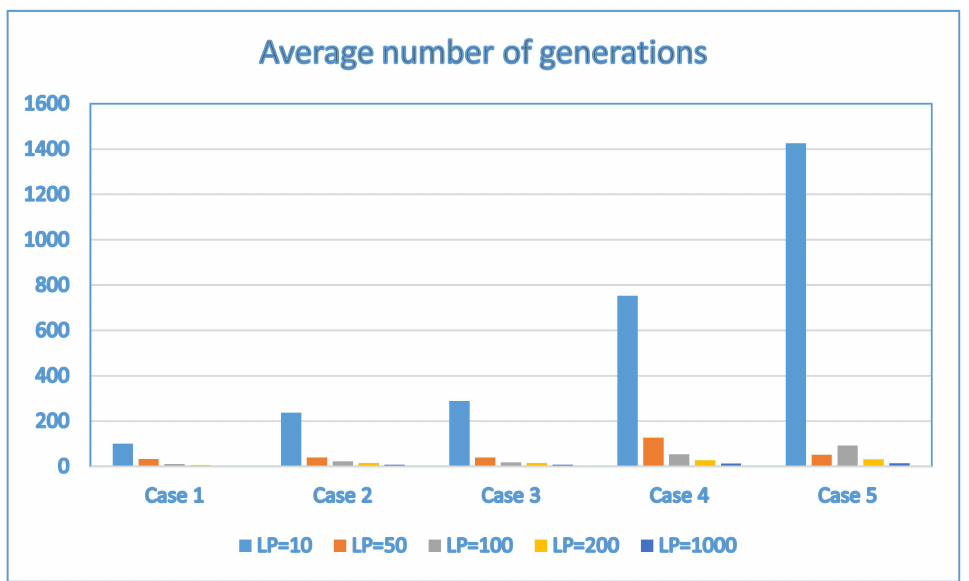
Figure 3. The average number of generations for Case 1, Case 2, Case 3, Case 4 and Case 5.